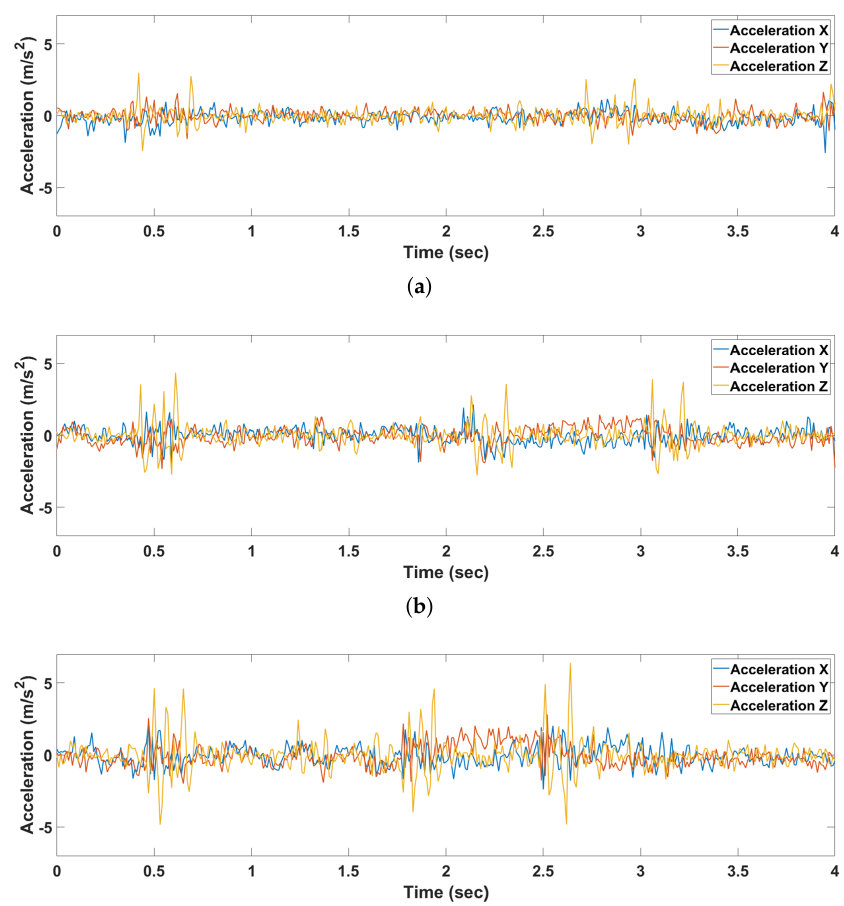
Figure 16. Comparison of 3-axis accelerations according to driving behavior: ( a ) Defensive driving. ( b ) Normal driving. ( c ) Aggressive